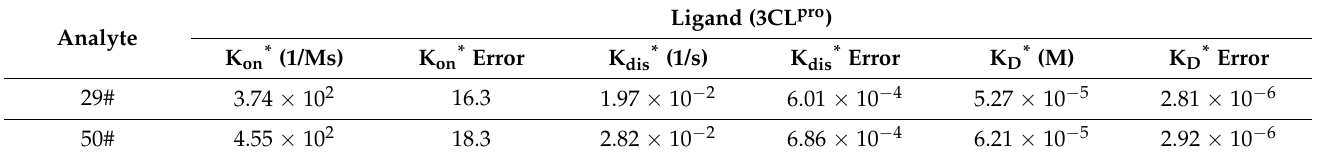
Table 2. Kinetics of 29# and 50# binding to the 3CL pro in the ForteBio’s Octet System. Analyte